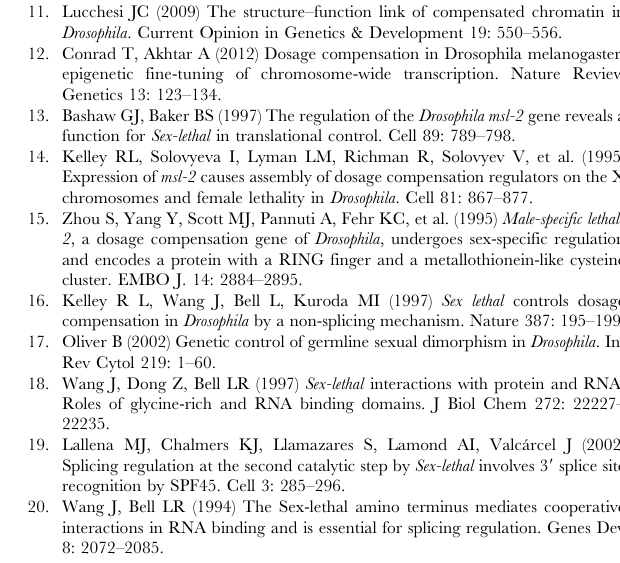
arrow in indicates the wells of the gel. (B) Western-blot to